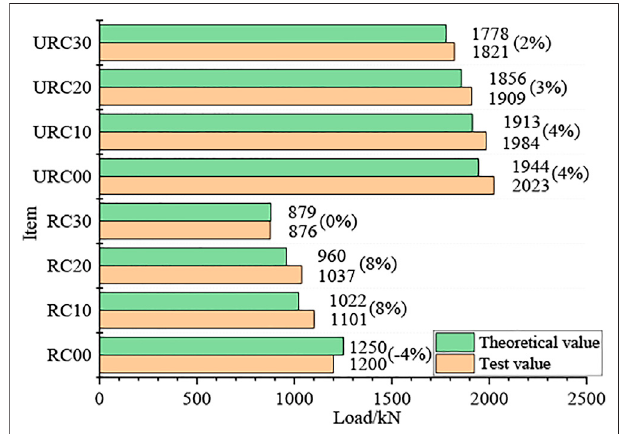
FIGURE 15 | Comparison of theoretical calculation results and experimental